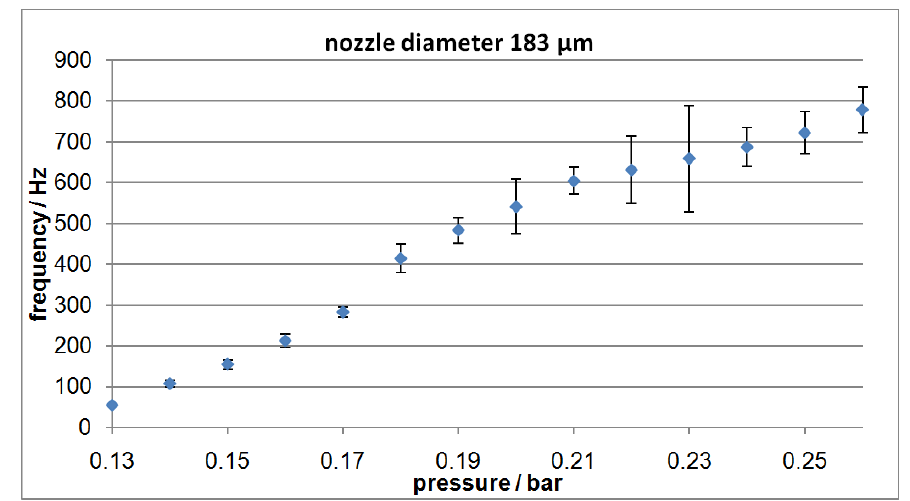
Figure 9. Droplet generation frequency as a function of the actuation pressure (one channel setup, nozzle chip (#12), number of measurements per data point N = 10.